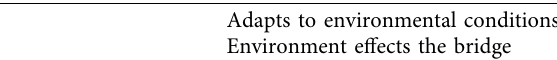
Table 2: Reference parameters α and β for ( C , ⊚ ) .